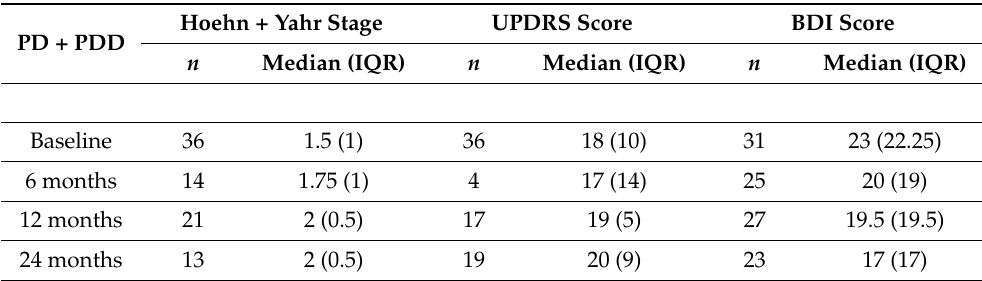
Table 2. Disease stage, motor symptoms, and depression scales at baseline and follow-up.